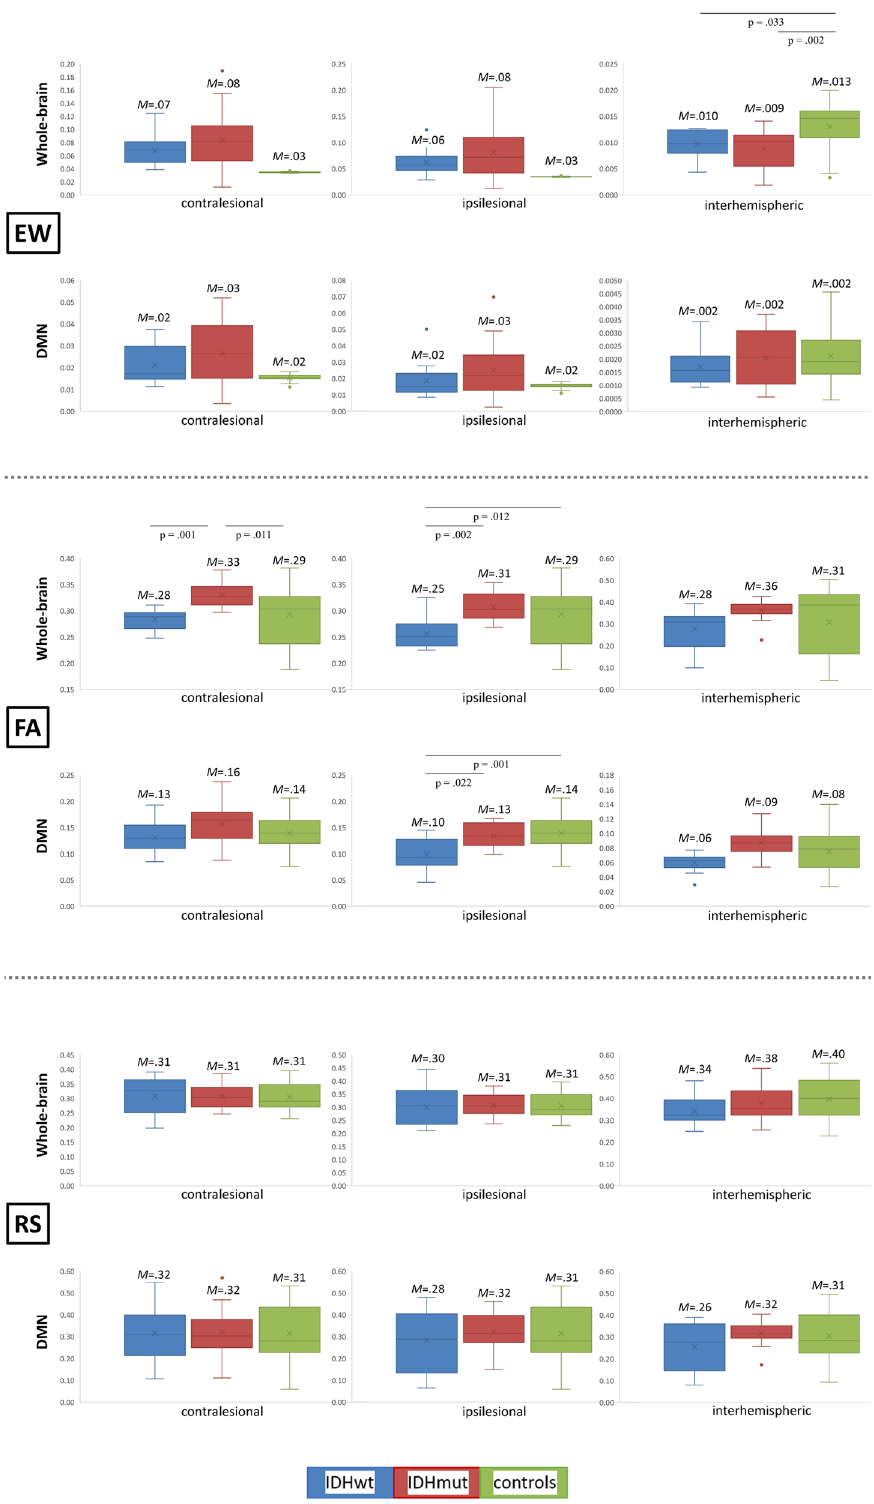
Figure 4. Group differences in structural and functional connectivity. Multivariate analyses of variance revealed group differences in edge weight (EW), fractional anisotropy (FA), and functional connectivity (FC) between isodehydrogenase-wildtype (IDHwt, blue), IDH-mutated gliomas (IDHwt, red), and healthy controls (green). Significances for each analysis were computed two-sided with a significance level of p < .05, including post-hoc